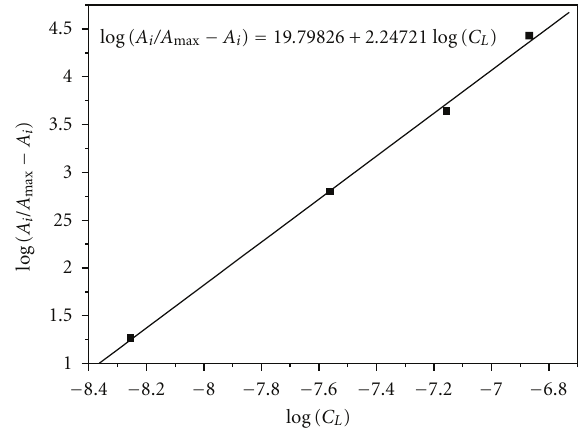
Figure 3: Log ( A i /A max – A i ) as a function of Log C L